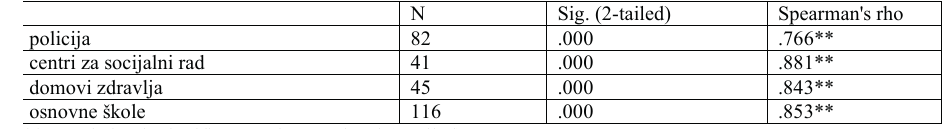
Tabela br. 1: Koeficijenti korelacije varijabli starost i ukupnog radno iskustvo zaposlenih